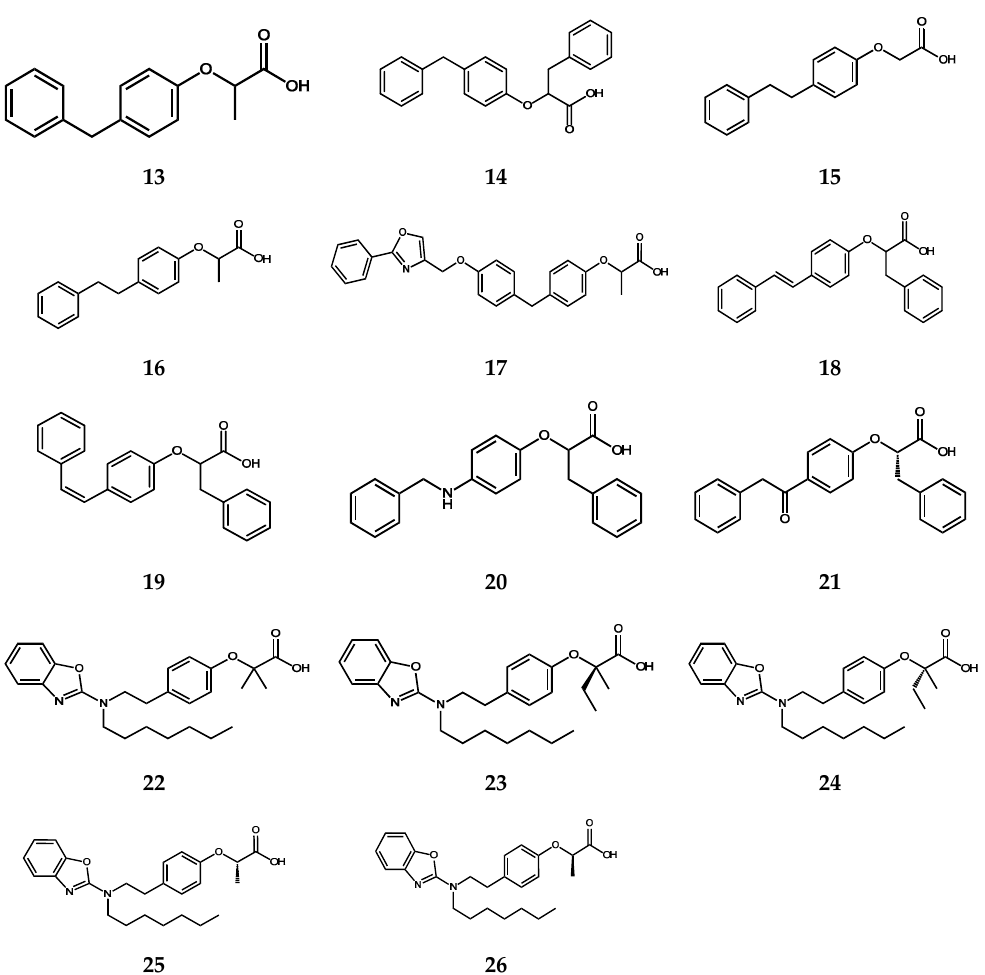
Figure 2. Molecular structures of phenoxyacetic analogues.